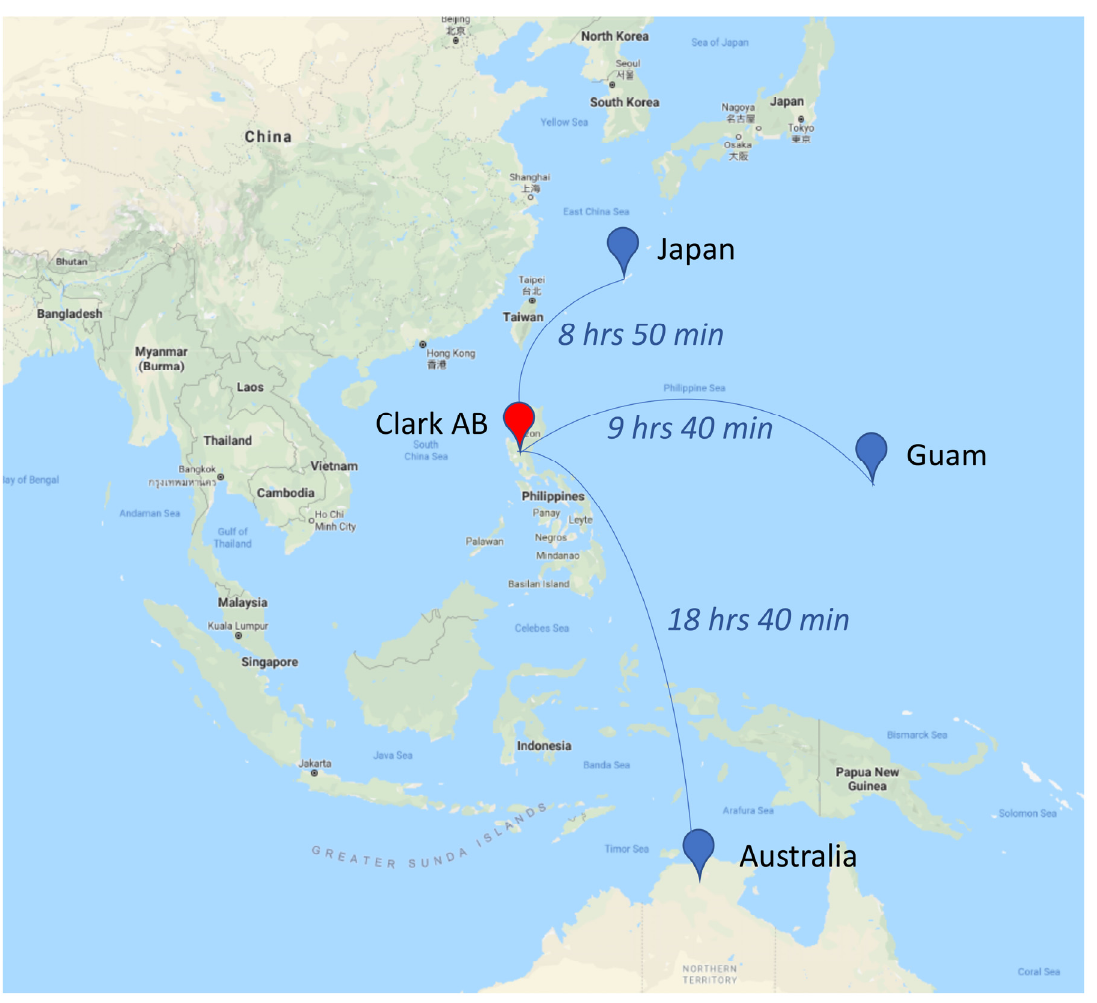
Figure 7. Estimated flight duration to Clark Air Base from three possible staging areas around the South China Sea [48].